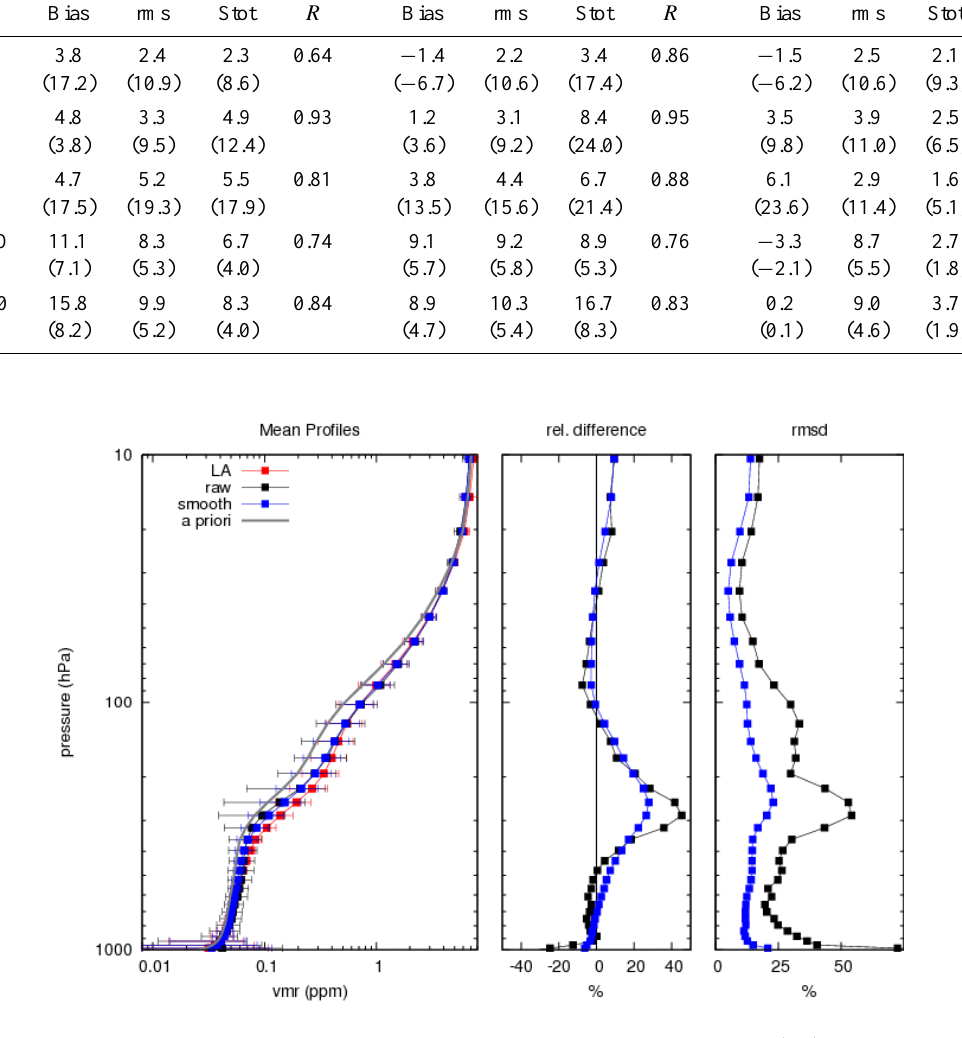
Fig. 3. Left panel: mean vertical profiles of ozone mixing ratios retrieved with the LA algorithm (red), measured by the ozonesondes (black), measured by the ozonesondes but smoothed with the averaging kernels of the LA retrieval (blue). The average is done over the entire validation period (year 2008) and for the midlatitudes. The mean a priori profile is also plotted (gray). Middle: vertical profiles of the difference between the retrieved profile and the measured (black) or measured and smoothed (blue) profile, given in percent. Right panel: vertical profiles of the rms of the previous differences, given in percent.